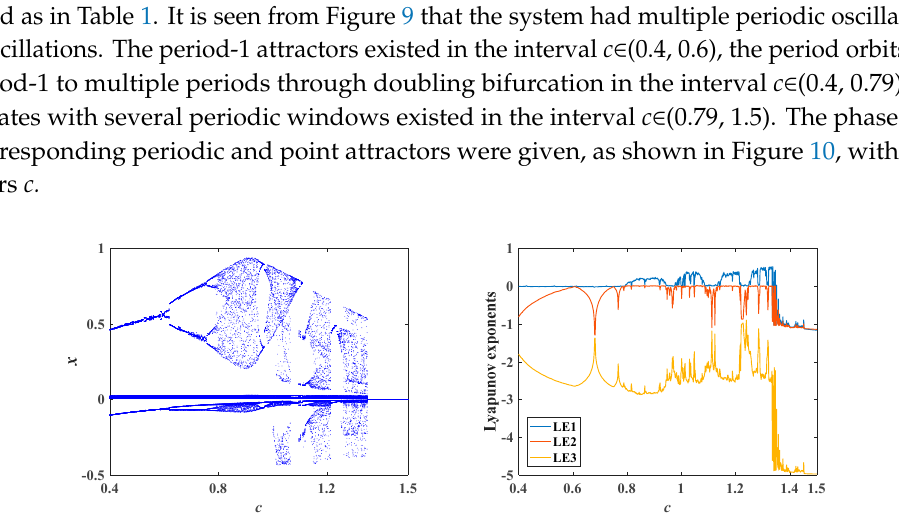
Figure 9. Dynamics of the system with the parameter c ∈ (0.4, 1.5): ( a ) bifurcation diagram; ( b ) Lyapunov exponents.